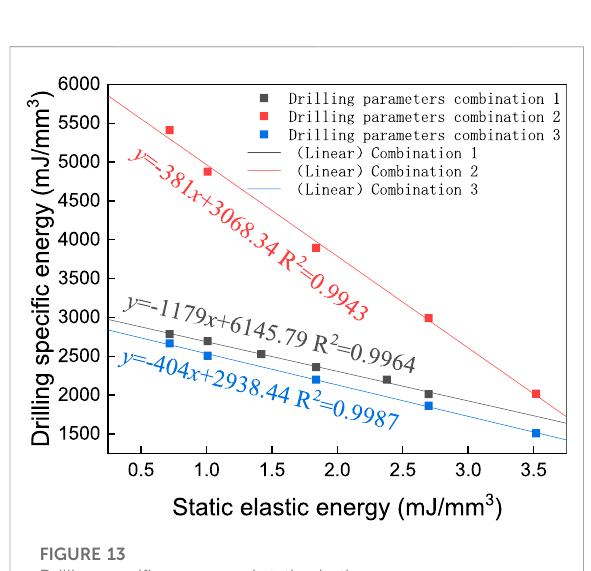
FIGURE 13 Drilling speci fi c energy and static elastic energy.